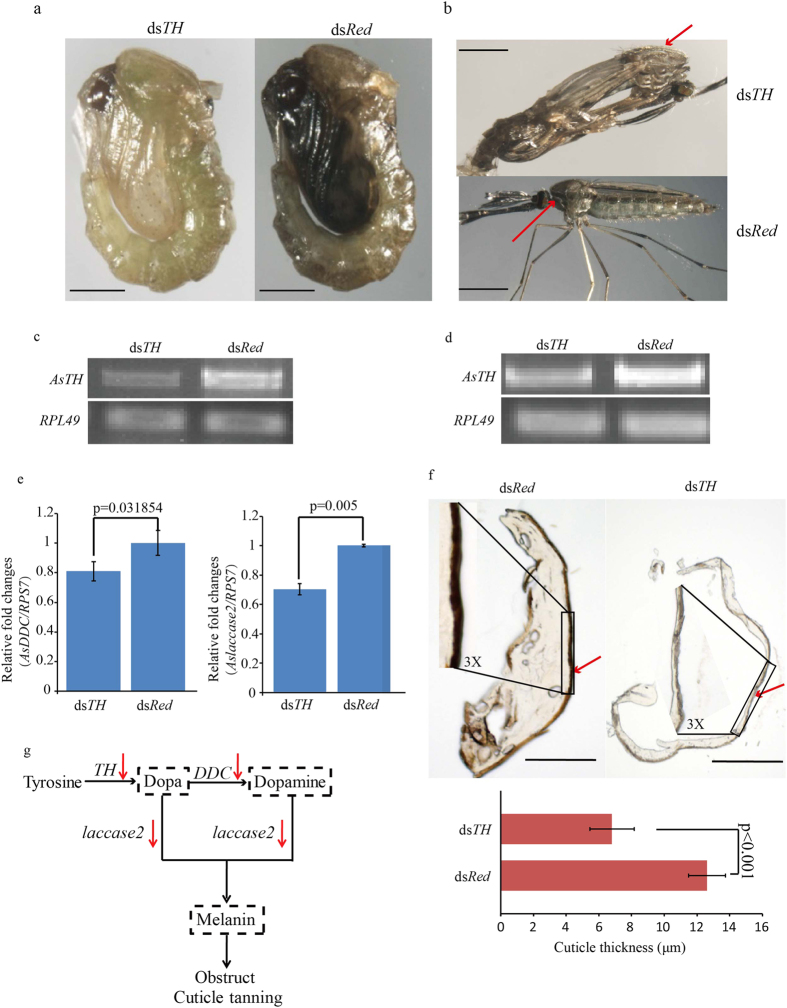
Effects of knockdown of AsTH during pupal developmental stages on cuticle tanning.(a) Pigmentation of pupae between the dsTH and dsRed groups at 38 h of pupation. Scale bar = 500 μm. (b) Eclosion and pigmentation states between dsTH and dsRed group adults at 6 h of eclosion. The red arrow indicates dorsal plates. Scale bar = 500 μm. (c) Expression levels of AsTH in dsTH and dsRed group pupae at 38 h of pupation. RPL49 was used as the internal control. (d) Expression levels of AsTH in dsTH and dsRed adults at 6 h of eclosion. RPL49 was used as the internal control. (e) Expression levels of AsDDC and Aslaccase2 (downstream genes of AsTH in the melanin metabolism pathway) at 38 h of pupation. RPS7 was used as the internal control (t-test, n = 3, p < 0.05 (for AsDDC), p < 0.01 (for Aslaccase2)). (f) Differences in color patterns and thickness of frozen sections of dorsal plates between dsTH and dsRed individuals. The red arrow represents across-section of the dorsal plate, and the black box represents the magnified area of the dorsal plate (scale bar = 200 μm). Magnification was described as X, t-test, n = 4, p < 0.001). (g) Schematic overview of cuticle tanning obstruction upon down regulation of AsTH expression. The red arrow represents suppression of gene expression, and the dotted frame signifies insufficiency of biochemical components.